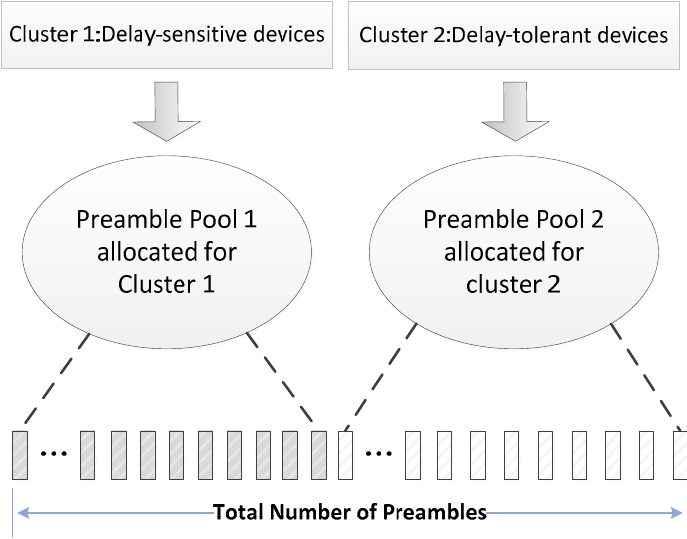
Figure 2. The diagram of conceptual design.